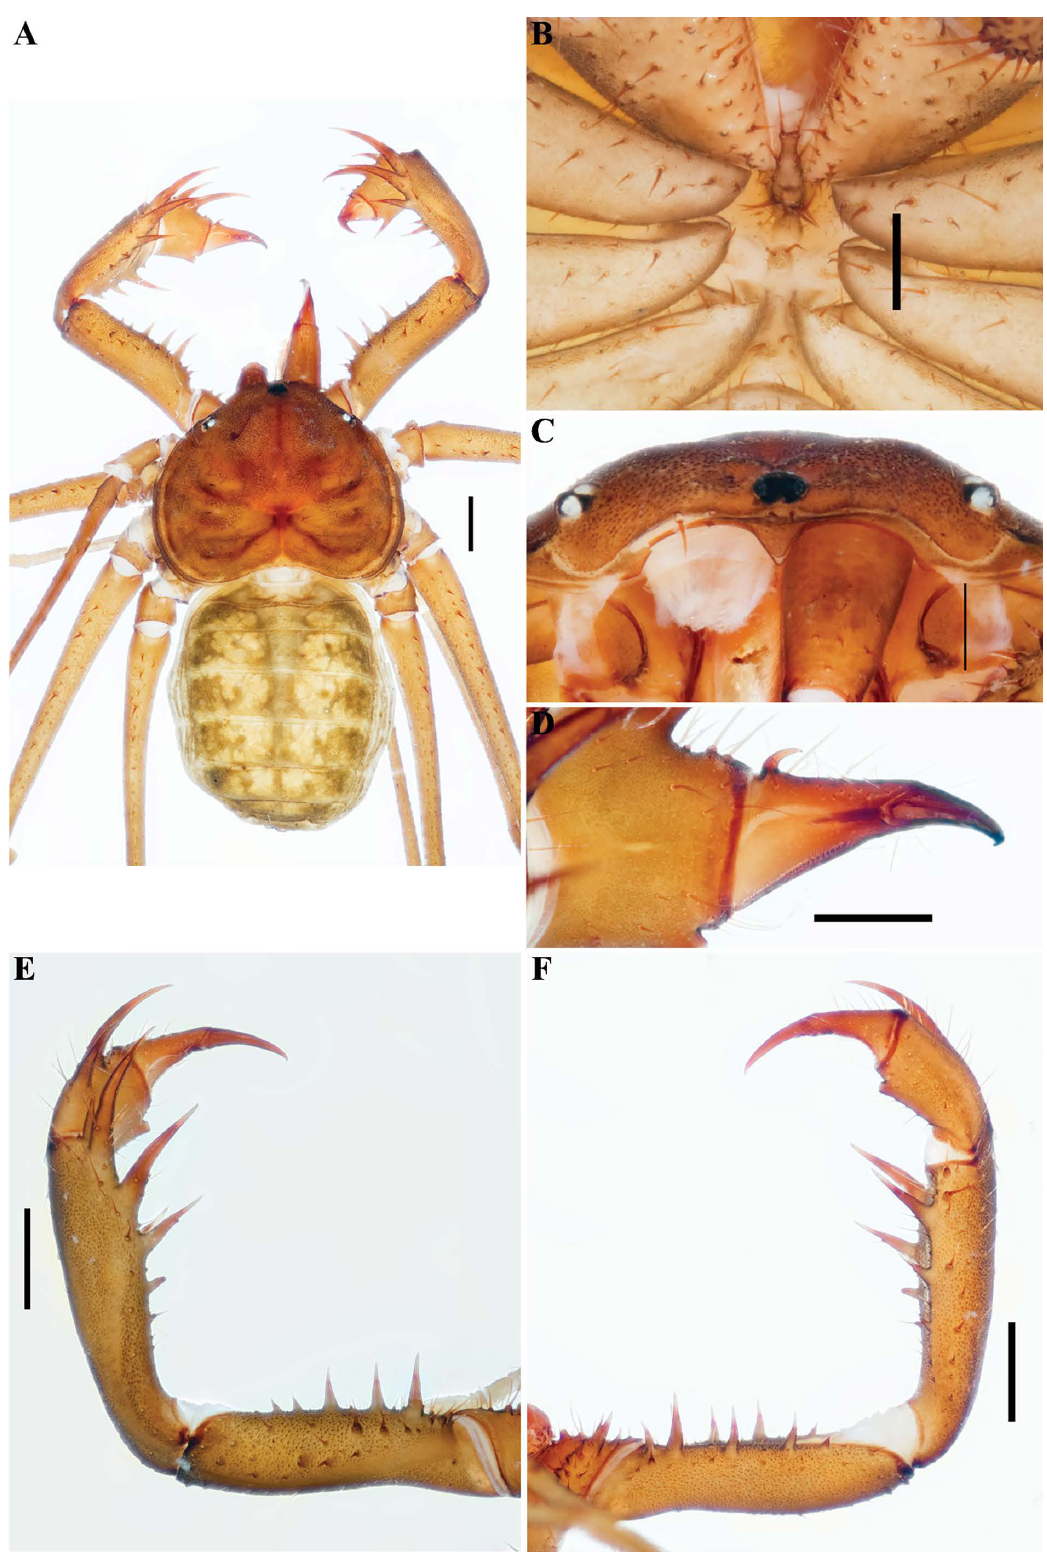
Fig. 105. Sarax bilua sp. nov. (AMCC [LP 5564]), general morphology, ♀ . A . Habitus, dorsal view. B . Sternum, ventral view. C . Frontal process. D . Pedipalp tarsus, frontal view. E . Pedipalp, dorsal view. F . Pedipalp, ventral view. Scale bars: A, E–F = 1 mm; B–D =